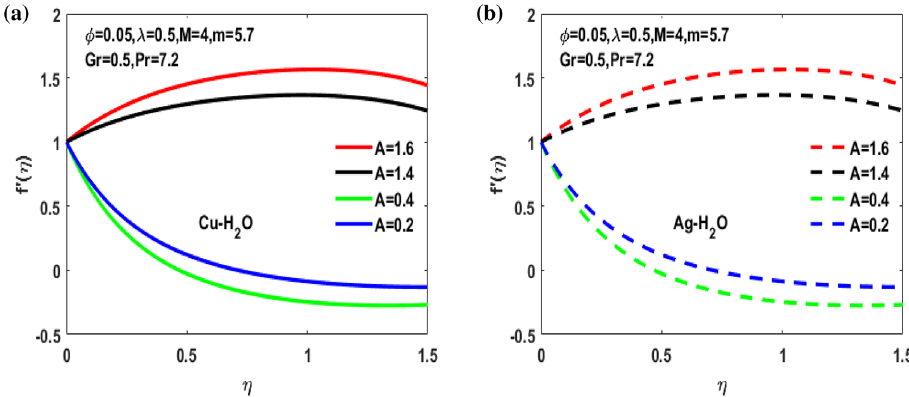
Figure 3. ( a ) Variation of A for f ′ (η) . ( b ) Variation of A for f ′ (η) .